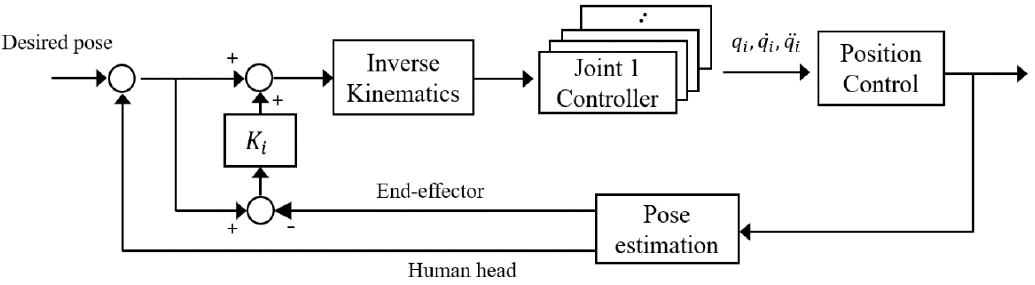
Figure 5. Block diagram of control and compensation.